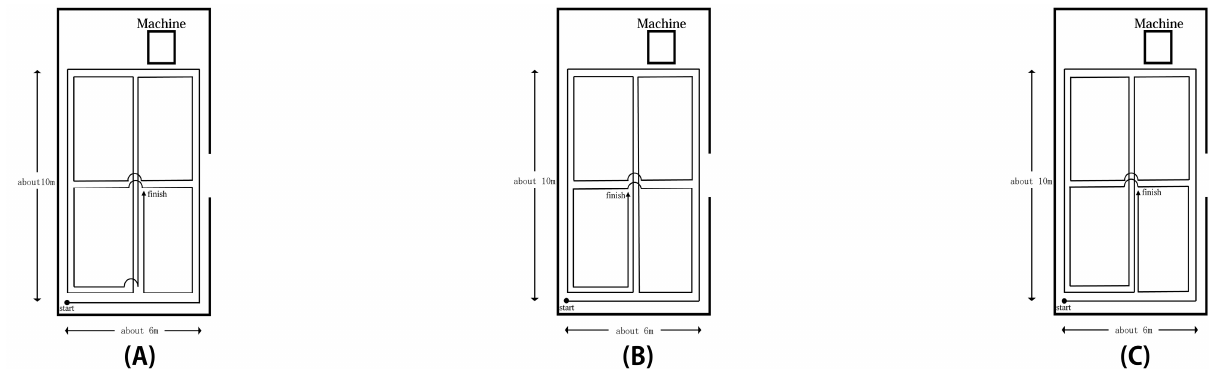
Figure 3. Walking path during the measurement. Considering the possibility of the direction of movement affecting the measurement results, the experiment was conducted for three different walking routes: ( A ) Experiments A; ( B ) Experiment B; ( C ) Experiment C. The start and end points of the three experiments were the same, but the turning directions along the routes were different, and the directions of travel were different.